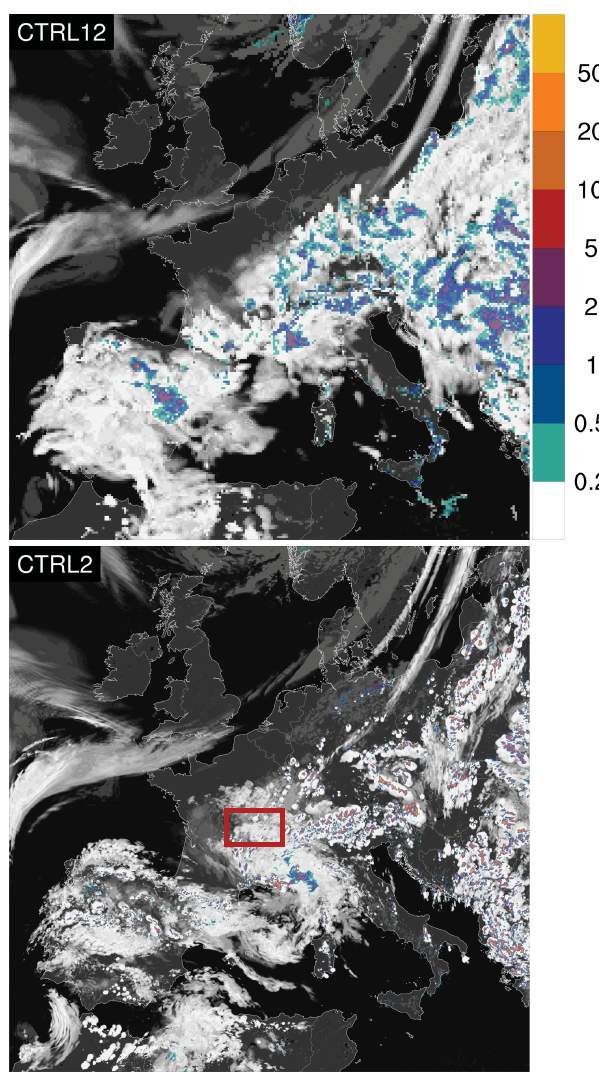
Figure 9. Summertime convection over continental Europe. Snap- shots on 13 June 2006, 12:00UTC from (top) CTRL2 and (bot- tom) CTRL12. The colored shading denotes the 15min precipita- tion [mmh − 1 ], and the grey shading a cloud visualization. The red box denotes a zoomed area used in Fig. 10. An animation of this display is available on the internet (Leutwyler et al.,